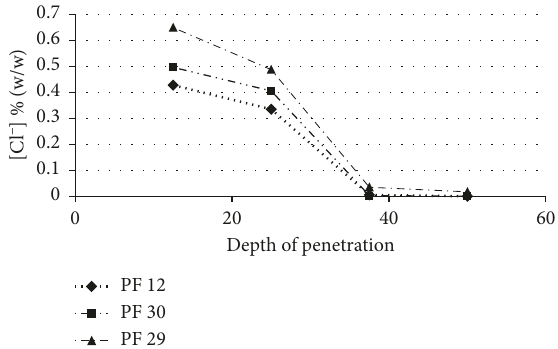
Figure 2: Results for chloride ingress versus depth from exposed surface for OPC − 25% PFA.